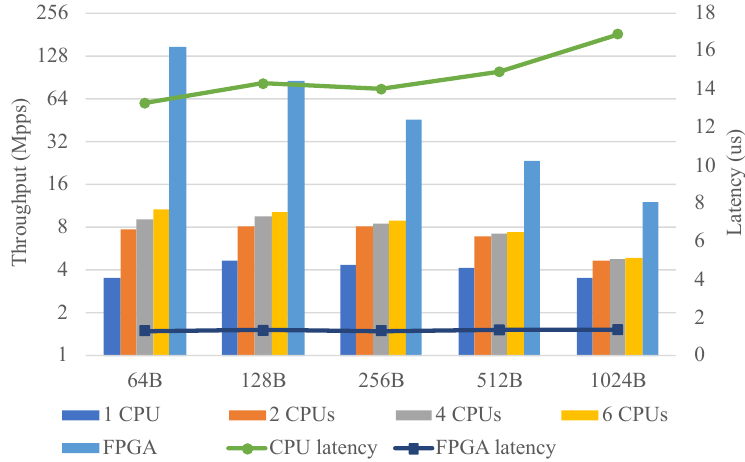
Figure 12. L2/L3 switch. The throughput and latency of the CPU and FPGA. Bars show the throughput, lines show the latency.